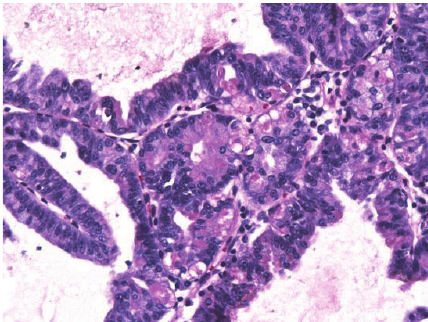
Figure 2: Irregularly branched neoplastic glands covered with the nonneoplastic foveolar epithelium (H&E × 40).